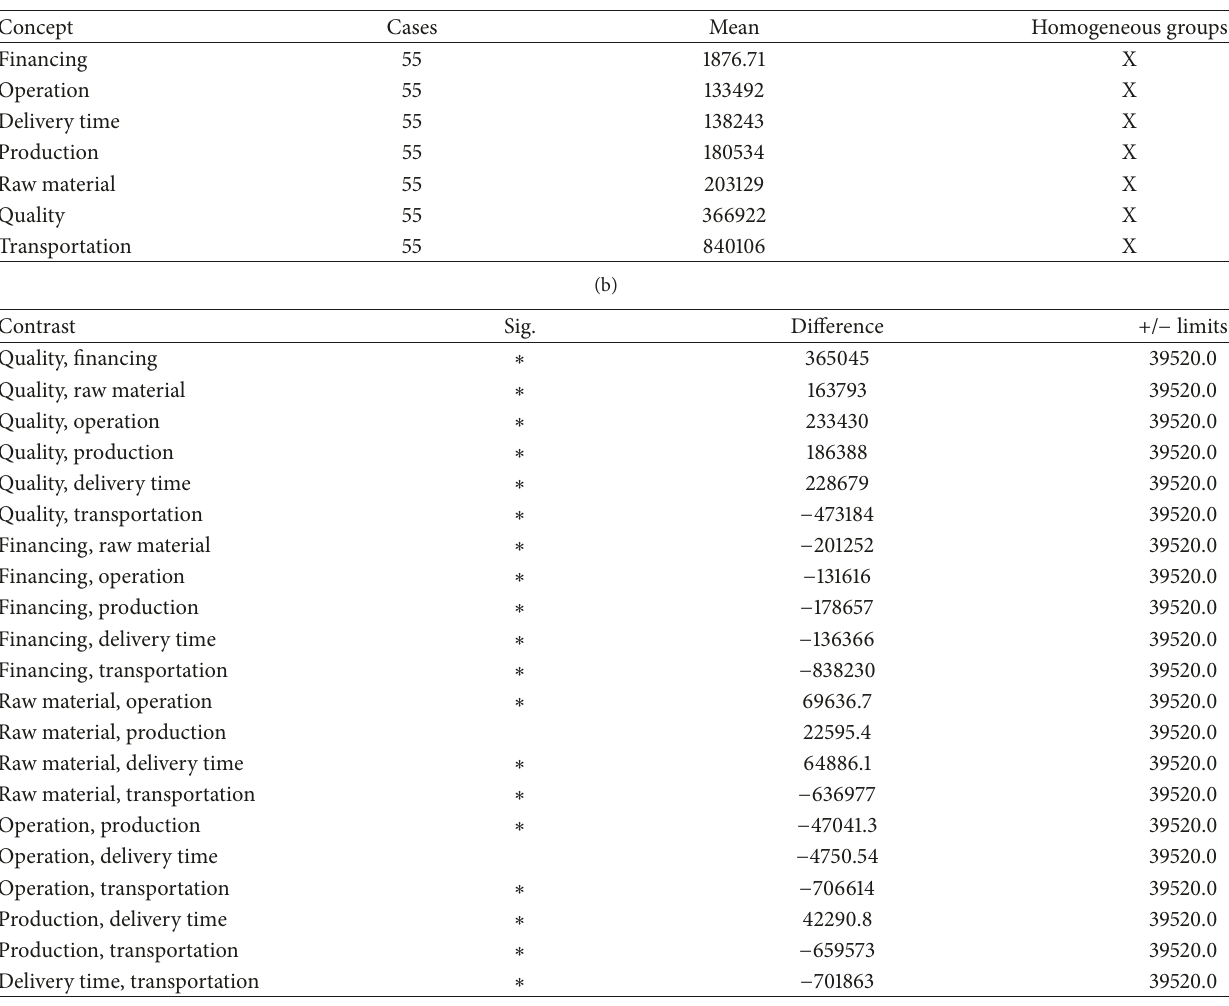
Table 7: Testing multiple ranges for costs.